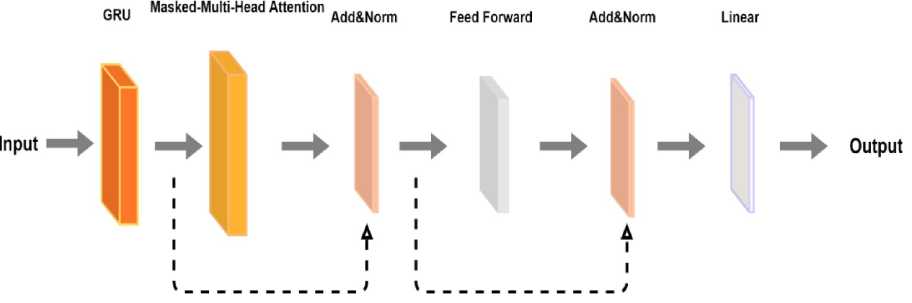
Fig 3. GRU—MMattention structure